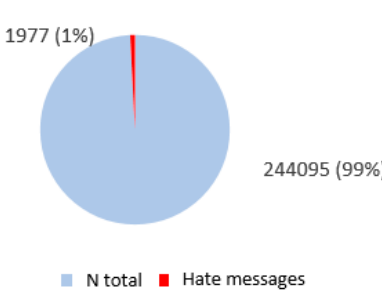
Figure 2. Proportion of hate messages inside of the total sample.